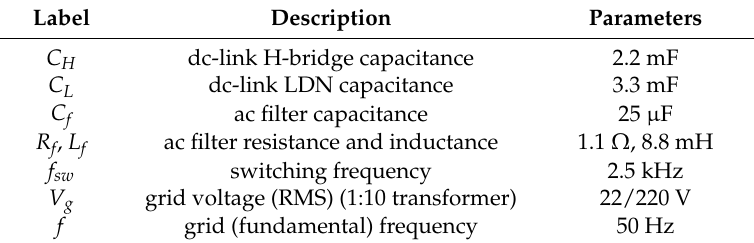
Table 2. Resistive dc source parameters.